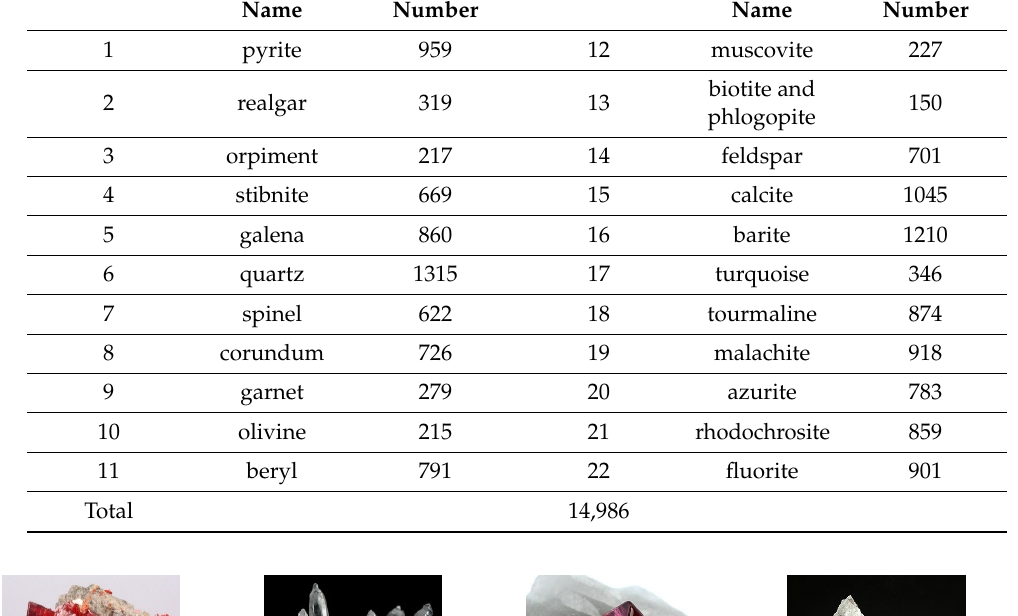
Table 2. Names and quantities of minerals in the dataset.